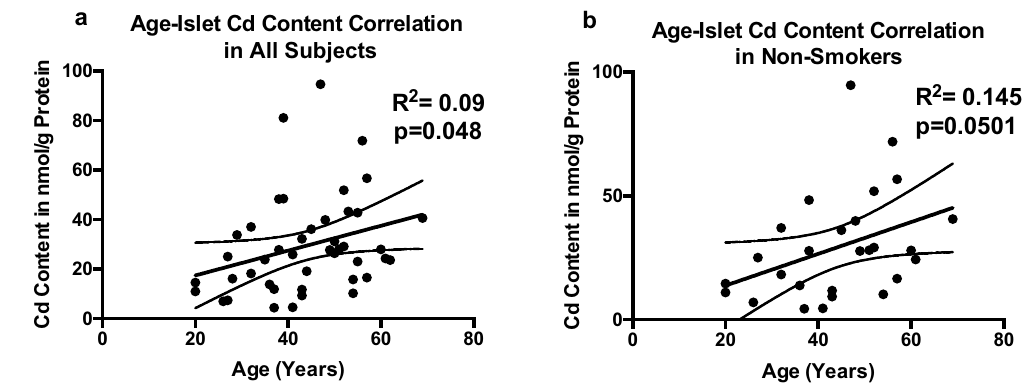
Figure 2. Correlation between age and islet Cd content in the overall cohort ( a ), and in non-smokers ( b ). Correlation analysis was performed using Spearman Correlation. Lines depict mean and 95%